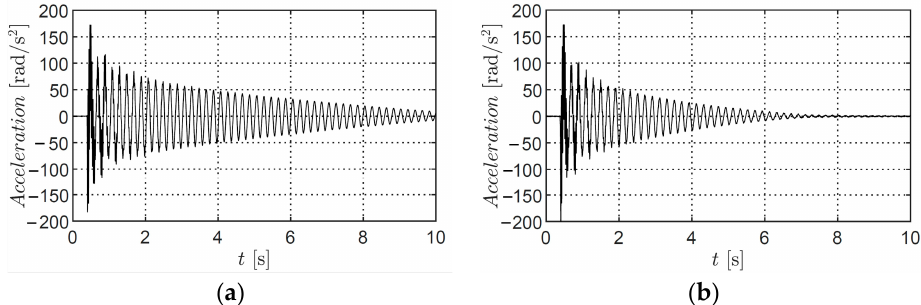
Figure 12. Recorded response of SDOF pitch: ( a ) raw acceleration time history at U = 0 m/s; ( b ) raw acceleration time history at U = 10 m/s.